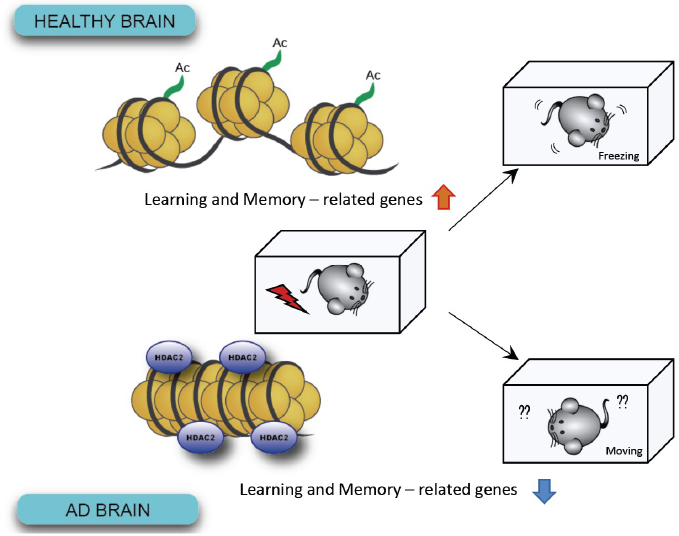
Figure 3. In AD brains, increased levels of HDAC2 have been shown to lead to defective chromosomes and reduced expression of genes associated with learning and memory.